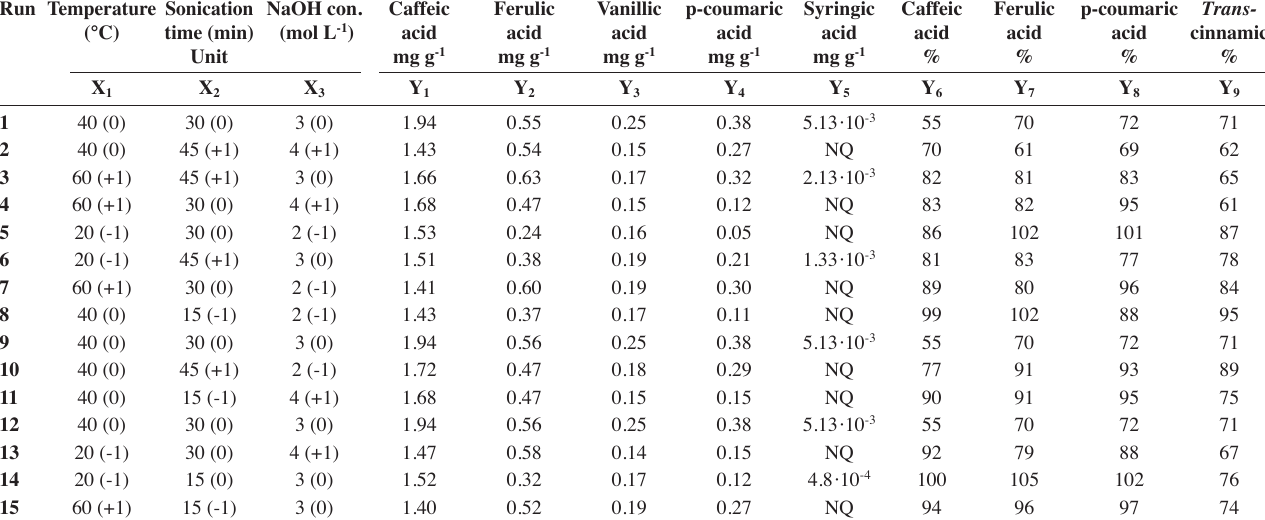
Fig. 2: GC chromatograms of: a) silylated standard mixture of phenolic acids (1. vanillic acid; 2. o-coumaric acid (ISTD); 3. protocatehuic acid; 4. syringic acid 5. cis -ferulic acid; 6. trans -p coumaric acid; 7. trans -cinnamic acid; 8. cis -caffeic acid; 9. trans -ferulic acid; 10. trans -caffeic acid); b) silylated phenolic acids present in Coriandrum sativum L. extract obtained after SPE (1. vanillic acid; 2. o-coumaric acid (ISTD); 3. protocatehuic acid; 4. syringic acid 5. cis -ferulic acid; 6. trans -p coumaric acid; 7. L-ascorbic acid (stabilizer); 8. cis -caffeic acid; 9. trans -ferulic acid; 10. trans -caffeic acid). Mean responses obtained for investigated phenolic acids from the experimental design. Run Temperature Sonication NaOH